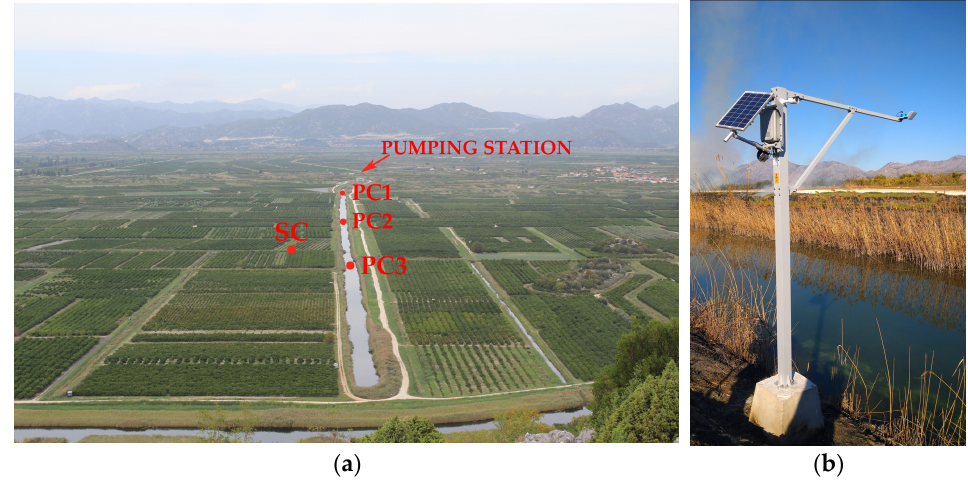
Figure 3. Location of the surface water regime monitoring stations PC1, PC2, PC3, and SC ( a ); photo of the monitoring station at the PC1 ( b ). Table 1. Summary of the data collected from the